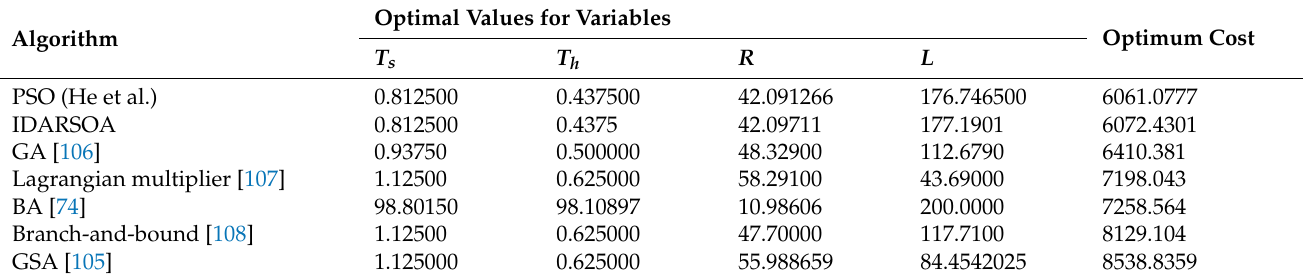
Table 12. Comparison results of pressure vessel design